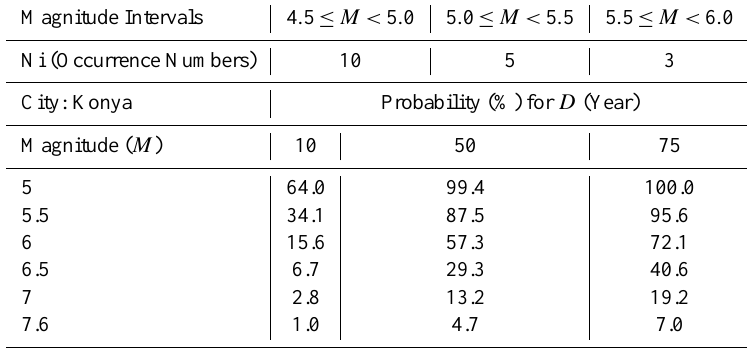
Table 3q. Earthquake occurrence probability (%) for D (Year) for Konya city. Magnitude